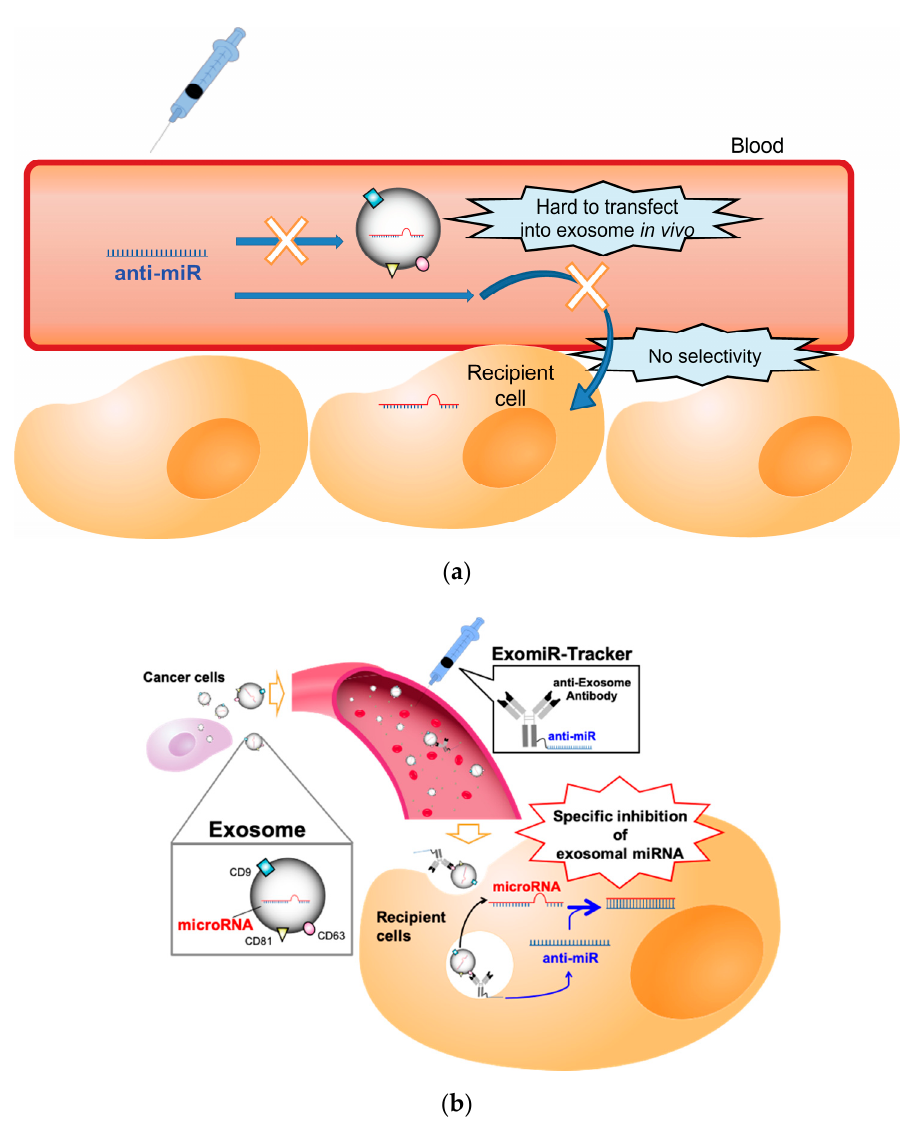
Figure 1. Schematic representation of the concept of this study: ( a ) The problems for targeting exosomal miRNA with anti-miR oligonucleotides in vivo. ( b ) ExomiR-Tracker binds onto the surface of the exosome, leading to incorporation into the cells and the subsequent inhibition of exosomal miRNA